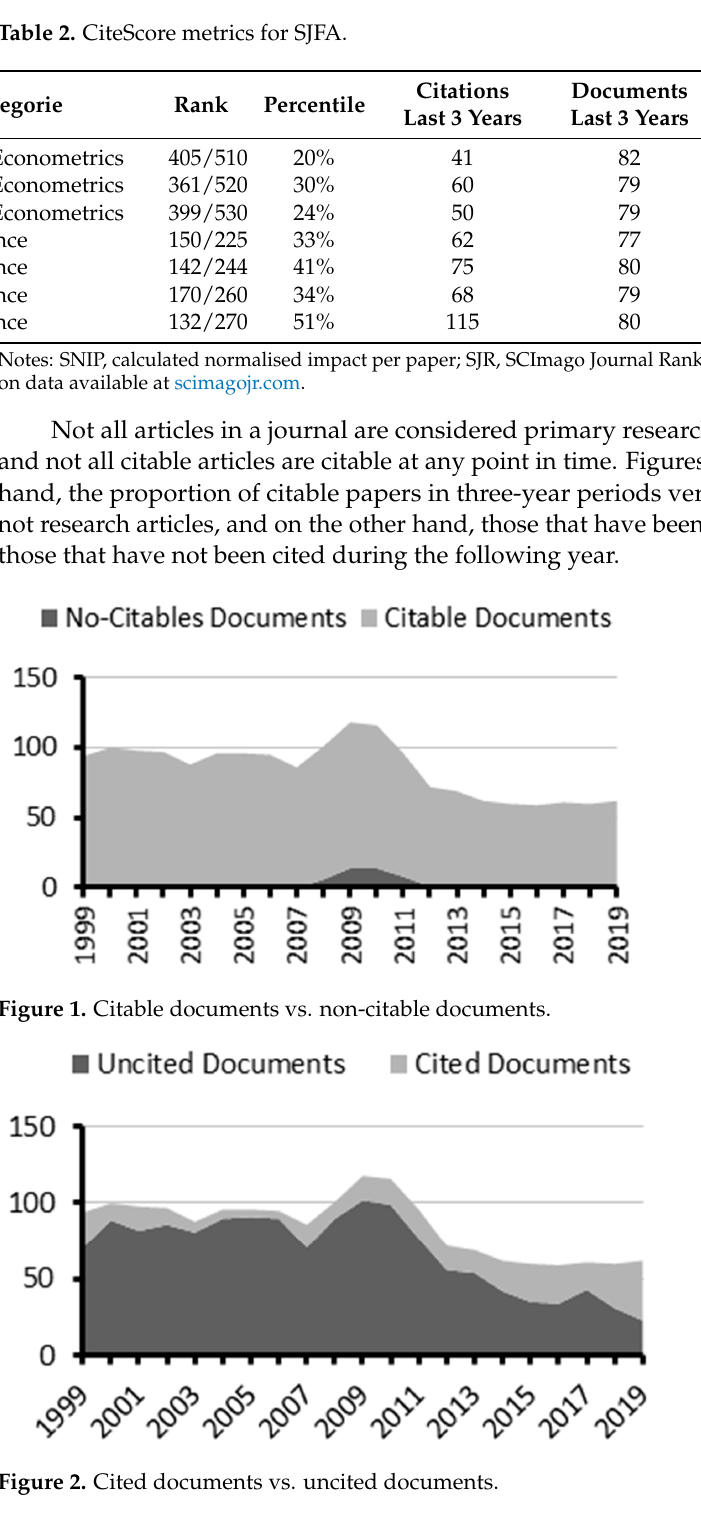
Figure 2. Cited documents vs. uncited documents.